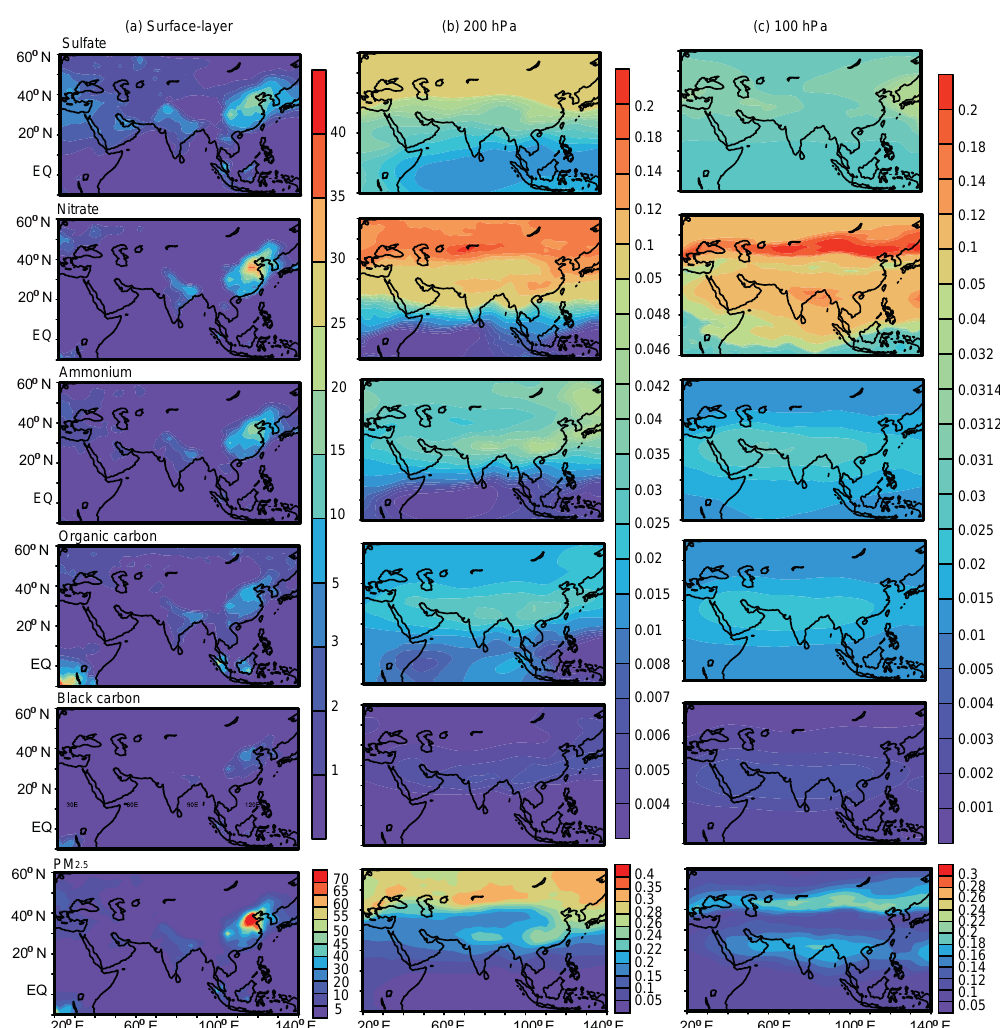
Figure 7. Simulated seasonal mean concentrations (µgm − 3 ) of sulfate, nitrate, ammonium, organic carbon, black carbon, and PM 2 . 5 (defined as the sum of sulfate, nitrate, ammonium, BC, and OC) at (a) the surface layer, (b) 200hPa, and (c) 100hPa, during summer (June–August) of year 2005. Note that color bars are different for concentrations at the surface, 200, and